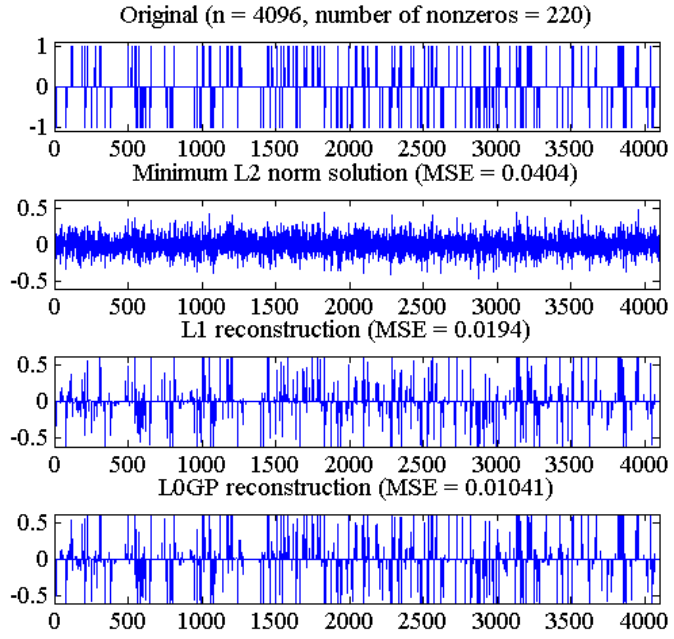
Figure 3. From top to bottom: original signal, reconstruction obtained by the minimum L 0 norm solution, L1_LS algorithm and the new proposed algorithm.